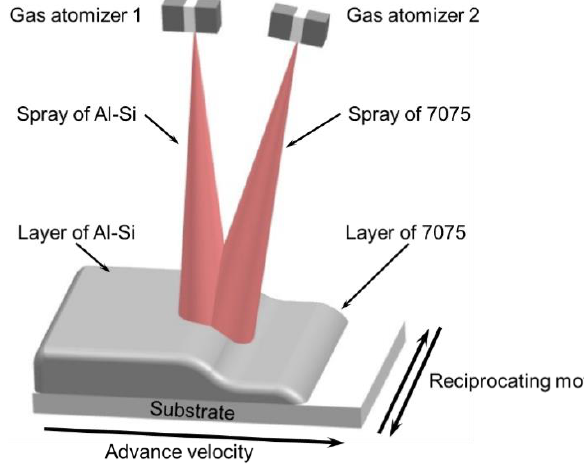
Figure 1. Diagram of the co-spray forming process principle.